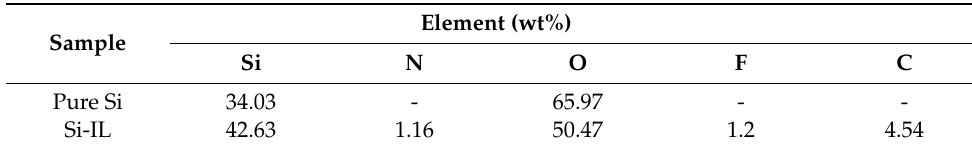
Table 2. Elemental composition of Sil and Sil-IL particles.